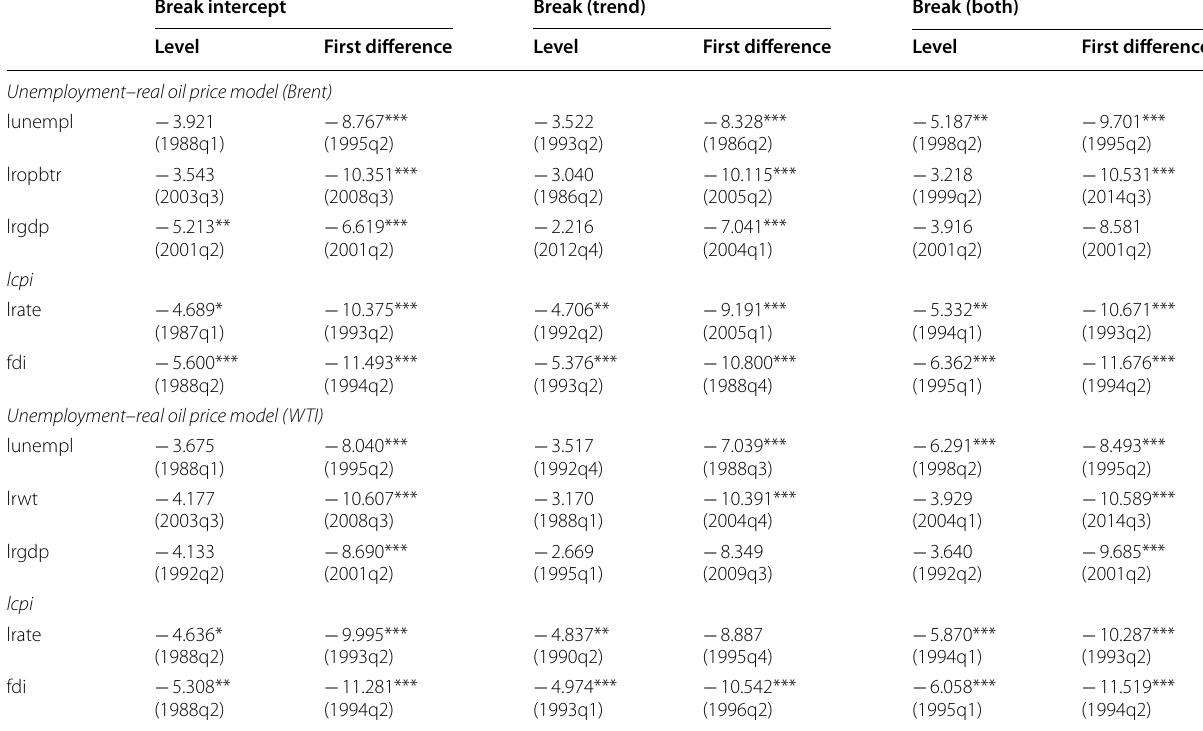
The values in brackets are the years when the structural break occurs for individual variable *, ** and *** represent 10%, 5% and 1% level of